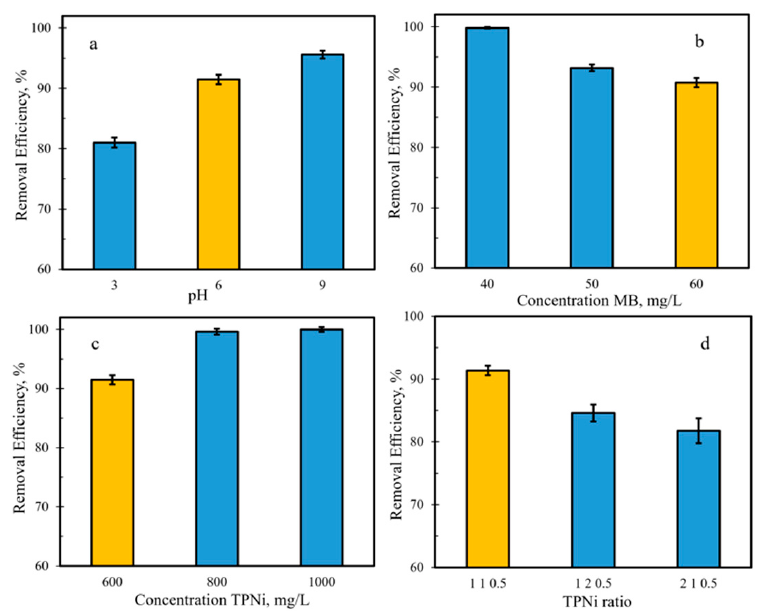
Figure 4. The effect of ( a ) pH, ( b ) concentration of MB, ( c ) concentration of TPNi carbon, and ( d ) TPNi mass ratio on the removal efficiency of MB by TPNi. Shown in yellow are the test conditions of pH 6, 60 mg/L MB, 600 mg/L TPNi, and 1:1:0.5 T:P:Ni ratio.